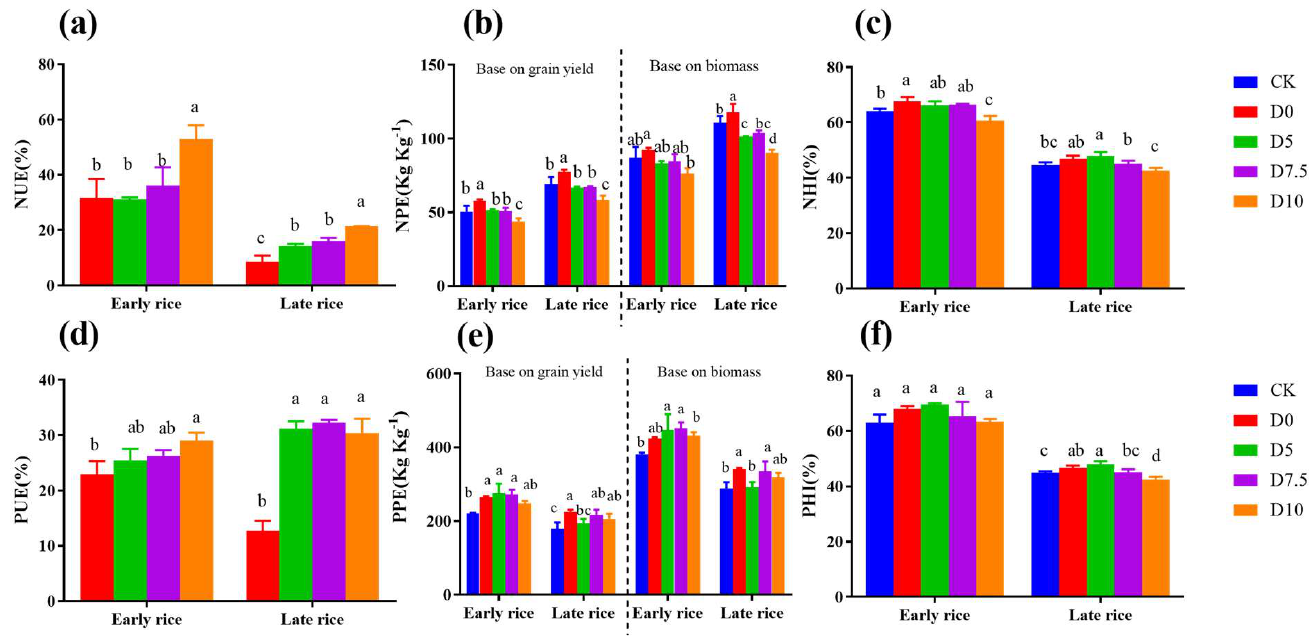
Figure 5. Early rice and late rice fertilizer-utilization rates under different depth fertilization treat- ments. ( a ): Nitrogen-use efficiency; ( b ): Nitrogen physiological efficiency; ( c ): Nitrogen harvest index; ( d ): Phosphorus-use efficiency; ( e ): Phosphorus physiological efficiency; ( f ): Phosphorus harvest index. CK: no fertilizer; D0: surface spreading; D5: 5 cm side-deep fertilization; D7.5: 7.5 cm side-deep fertilization; D10: 10 cm side-deep fertilization. Different lowercase letters in the figure indicate significant difference among treatments at P = 0.05 (LSD).